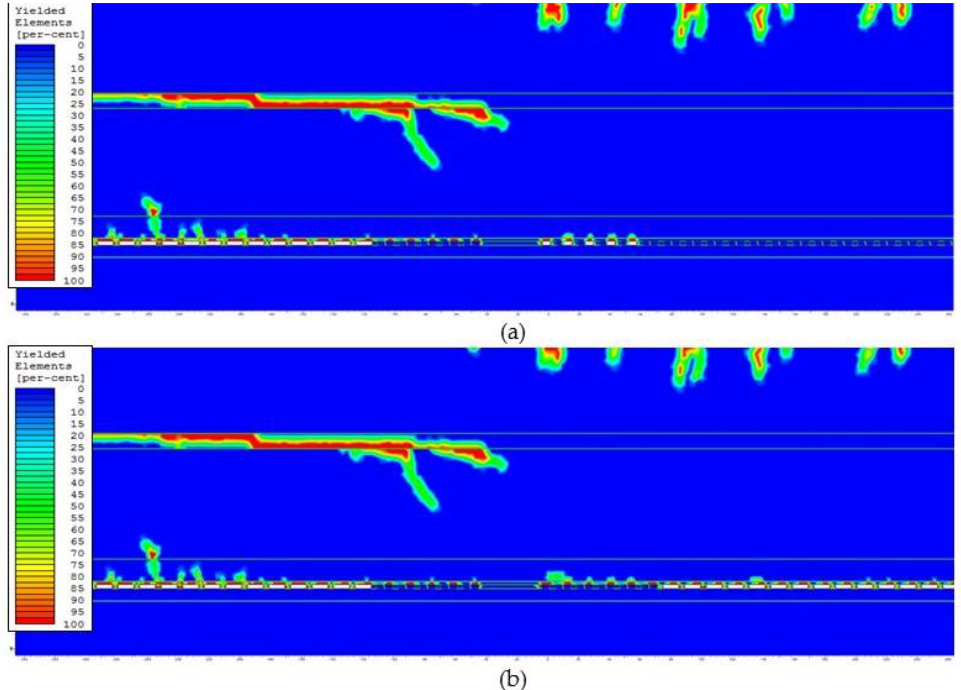
Figure 10. Yielded zones for mining front: ( a ) approximately 60 m from the remnant edge — 36th calculation step, ( b ) ap- proximately 470 m from the remnant edge — 65th calculation step.